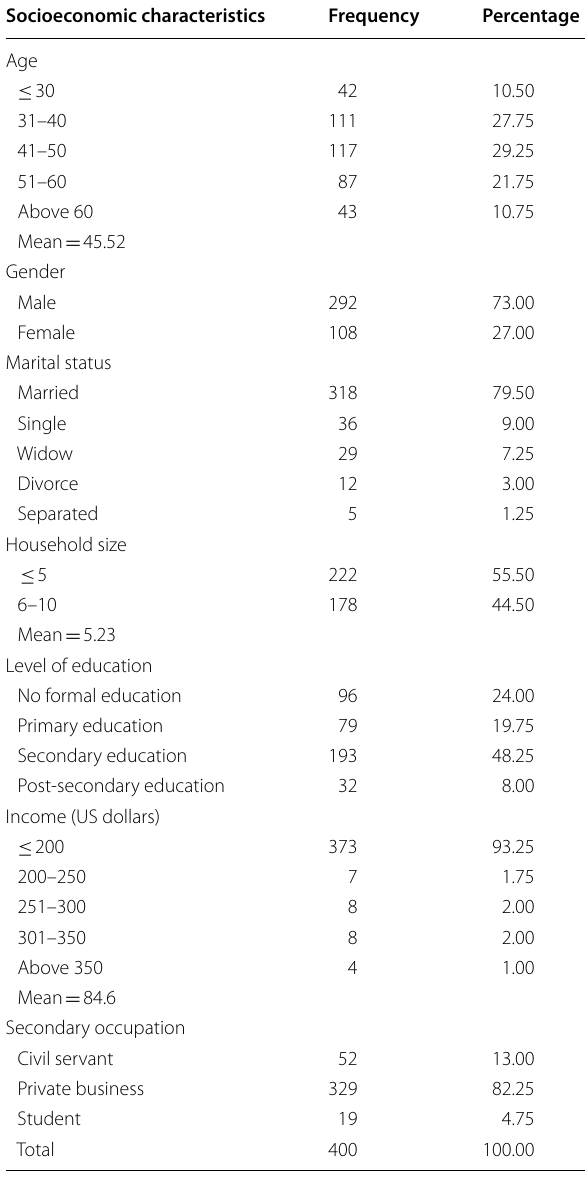
Table 1 Socioeconomic characteristics of the respondents (N 400). Source : Field Survey, =